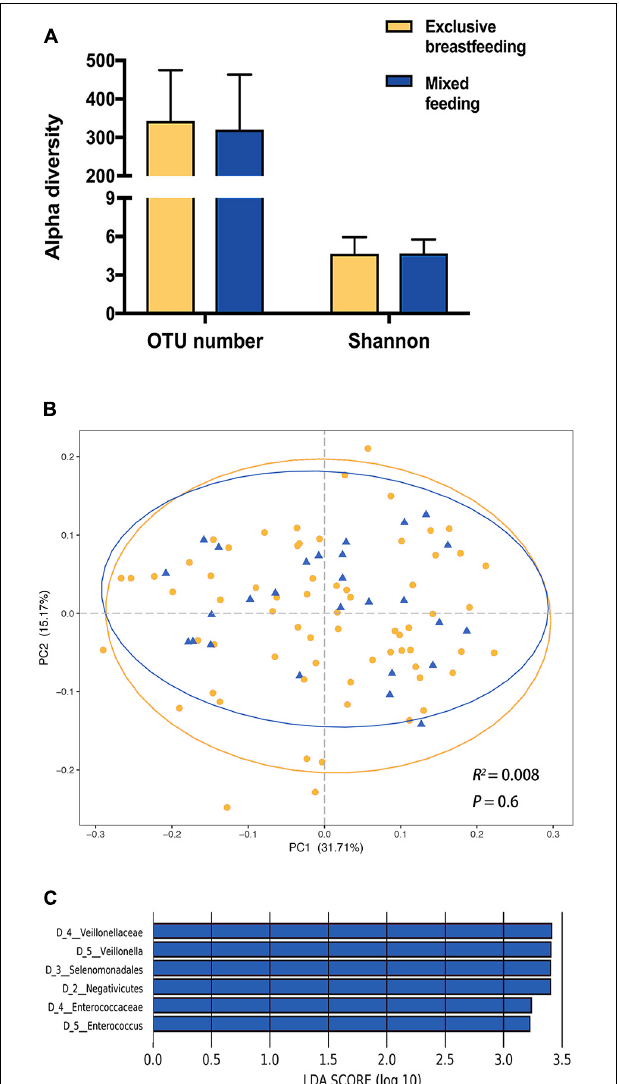
FIGURE 1 | The impact of delivery mode on infant gut microbiota. (A) Comparison of alpha diversity between vaginally delivered and cesarean delivered infants. (B) Principal coordinates analysis (PCoA) based on weighted UniFrac distances is shown along the first two principal coordinate (PC) axes with Adonis p -value. Percentages are the percent variation explained by each PC axis. Individual samples are represented by green triangles (vaginally delivered) and red points (cesarean delivered). (C) Enriched taxa of different level from vaginally delivered infants with a positive linear discriminant analysis (LDA) score are shown in green; cesarean delivered infants with negative LDA score are shown in red (cut off value ≥ 3).